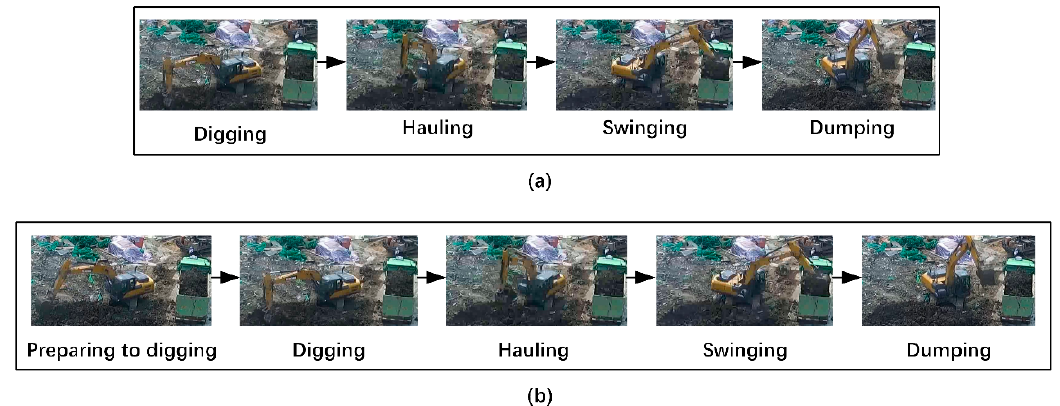
Figure 1. Atomic actions of an earthmoving excavator intercepted in a long video sequence: ( a ) four-atomic-action sequential pattern and ( b ) five-atomic-action sequential pattern.